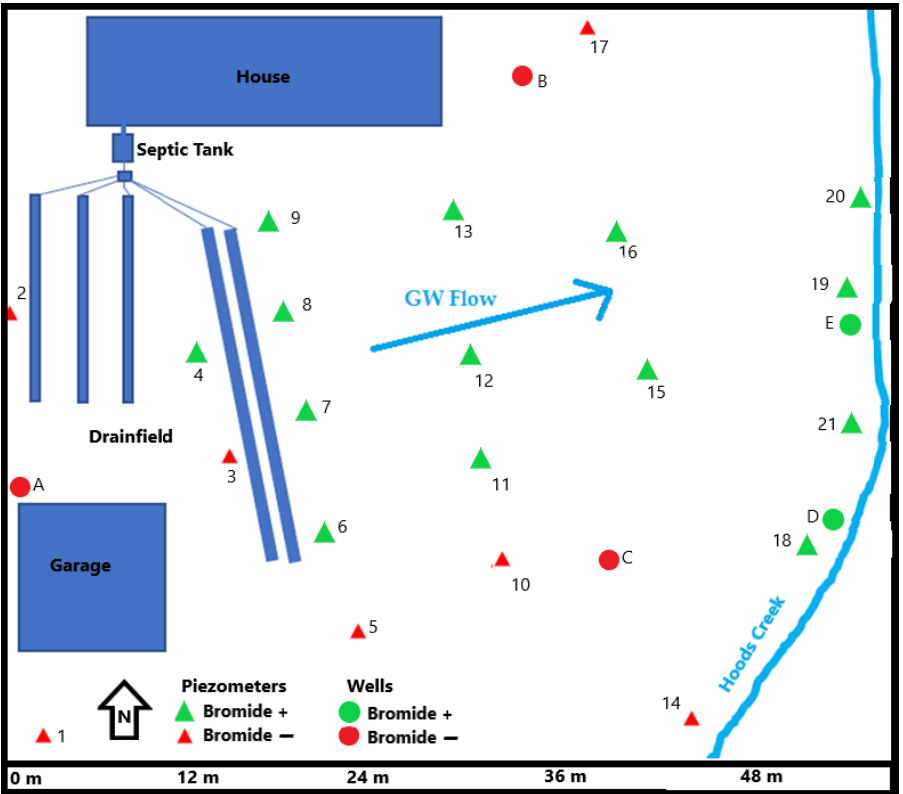
Figure 3. Groundwater monitoring infrastructure at Site 2, including wells and nests of piezometers between the drainfield and creek. Bromide tracer was in the groundwater sampled from piezometer nests including 6 – 9, 11 – 13, 15, 16, 18 – 21, and wells D and E.